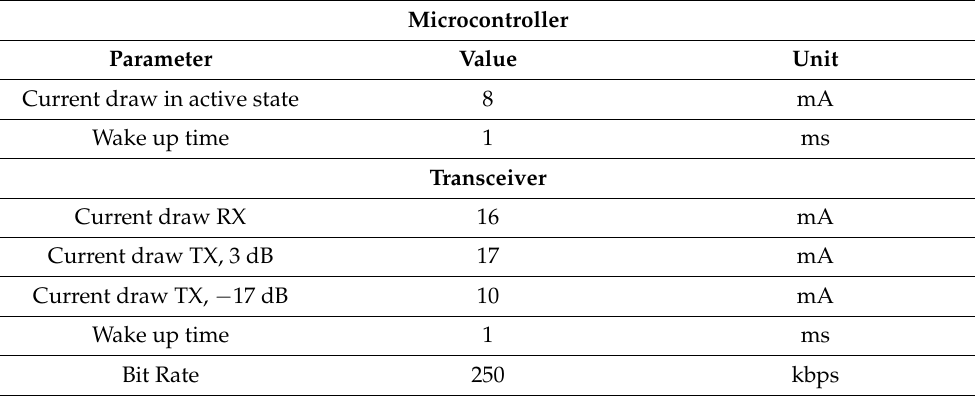
Table 3. Energy-related simulation parameters for the microcontroller and